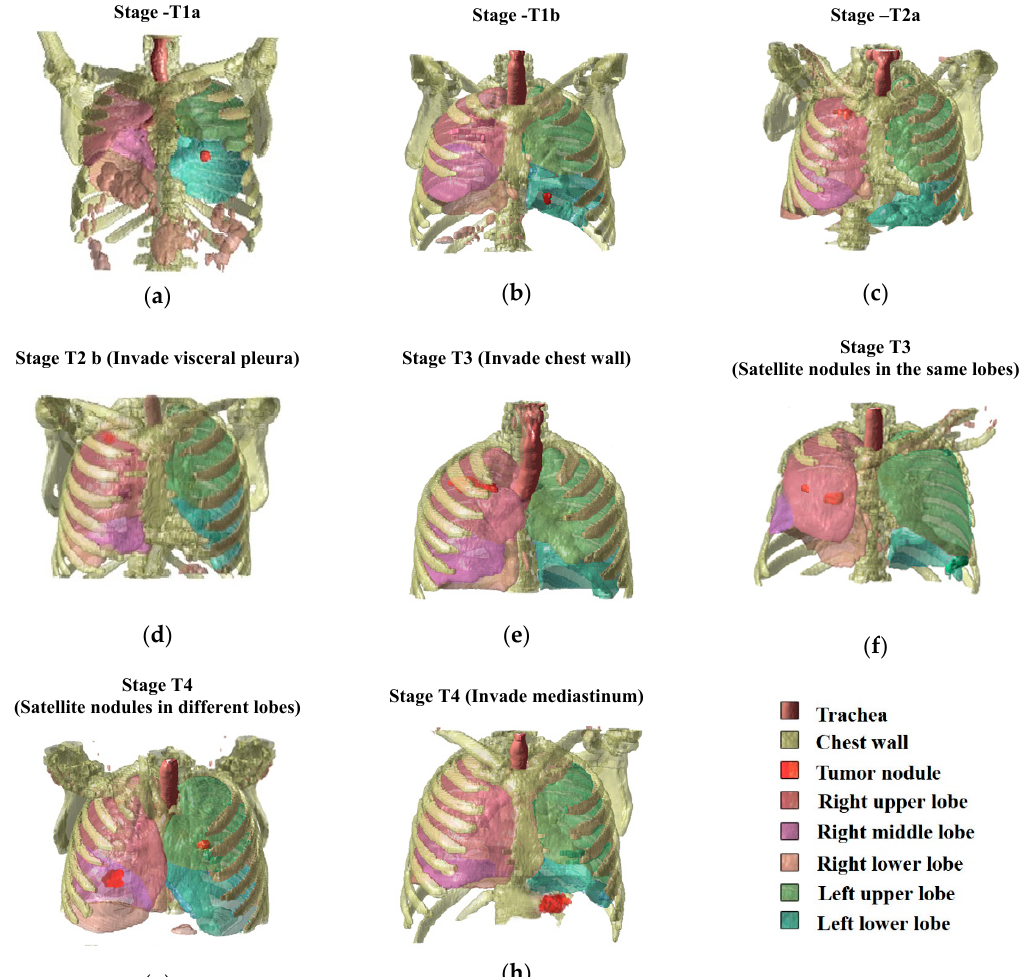
Figure 16. Three-dimensional visualization for some example outputs of the proposed CAD: ( a ) T1a-staged tumor nodule, ( b ) T1b-staged tumor nodule, ( c ) T1b-staged tumor nodule, ( d ) T2b-staged tumor nodule which invades the pleura, ( e ) T3-staged tumor nodule which invades the chest wall, ( f ) T3-staged tumor nodule with satellite nodules in the same lobe, ( g ) T4-staged tumor nodule with satellite nodules in different lobes, ( h ) T4-staged tumor nodule which invades the diaphragm.